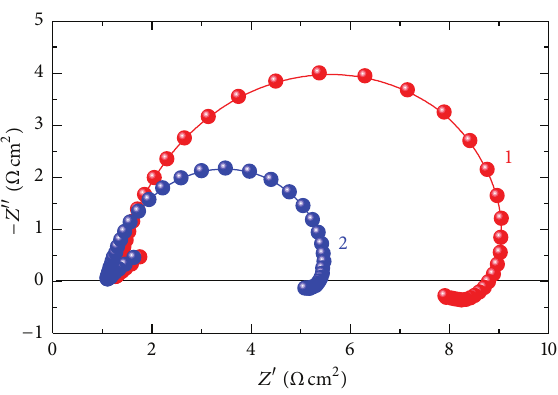
Figure 3: Nyquist plots for the HSLA steel after its immersion for (1) 10 min and (2) 60 min in the 2.0 M H 2 SO 4 solutions, respectively.